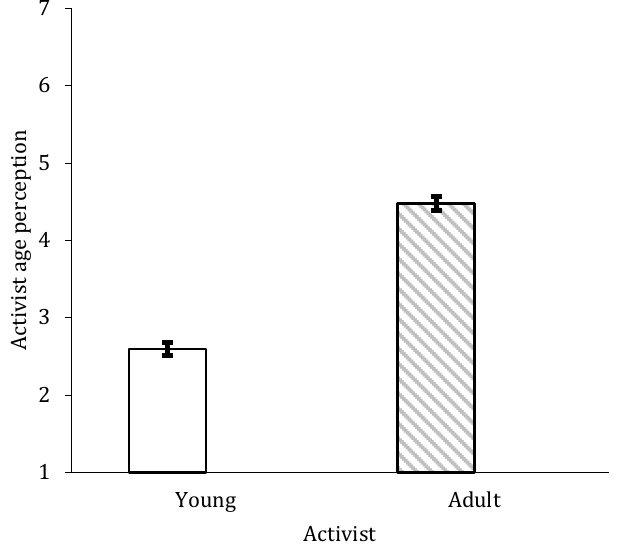
Figure 1. Means and standard errors regarding the activists’ perceived age by experimental conditions.